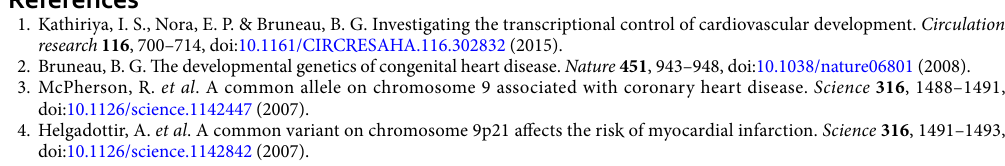
In situ hybridization. In situ hybridization riboprobes were generated from 500- to 1,000-bp PCR products using T7-tagged primer pairs. Fish embryos were collected at 1, 2, and 4 dpf. Whole-mount in situ hybridization was conducted as described previously 69 . Images were recorded using an Axioplan 2 microscope (Zeiss) or a Leica III dissecting microscope equipped with a Nikon digital